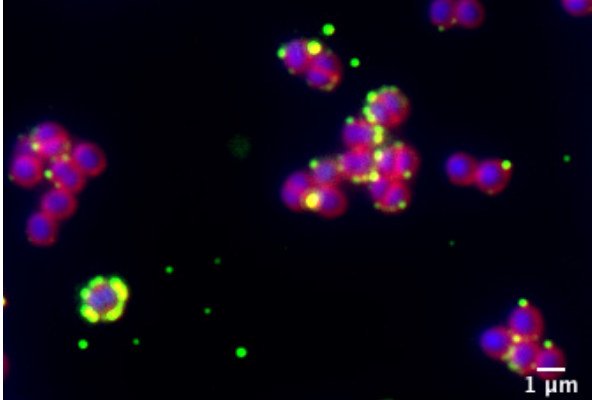
Figure 11. NLC-SF interacts with S. aureus cells in liquid culture; NLC-SF was stained with DiO (green), S. aureus membranes were labelled with Nile Red (red) and DNA was labelled with Hoechst (blue).